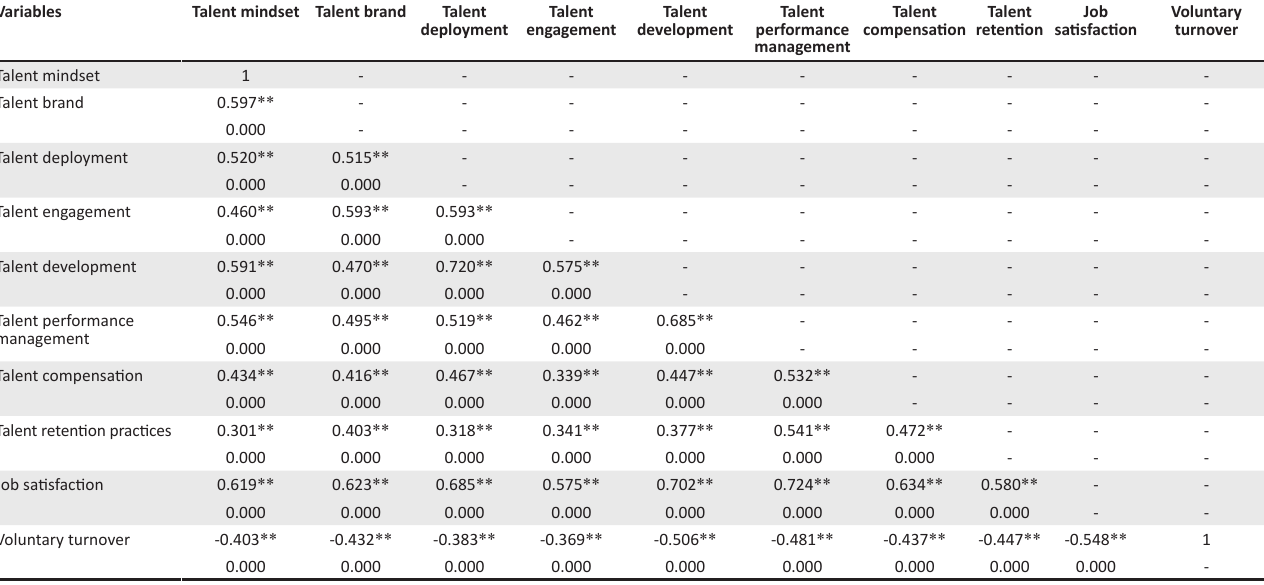
TABLE 2: Pearson correlation analyses between talent management, job satisfaction and voluntary turnover intentions.